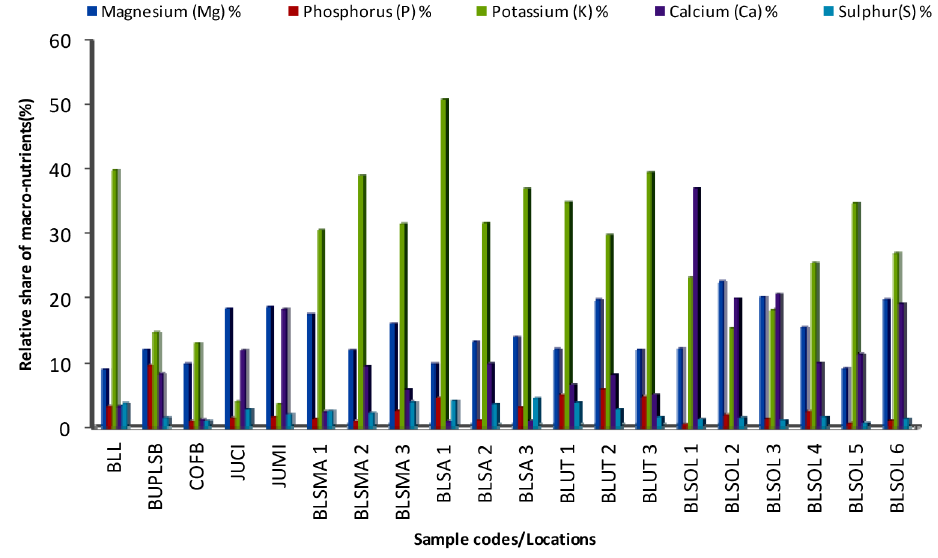
Figure 1. Concentrations of macro-nutrients (% by weight) in ash samples of plant tissues